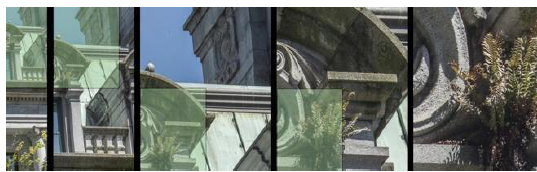
Figure 2: Multi-resolution tiled images for efficient dissemination.